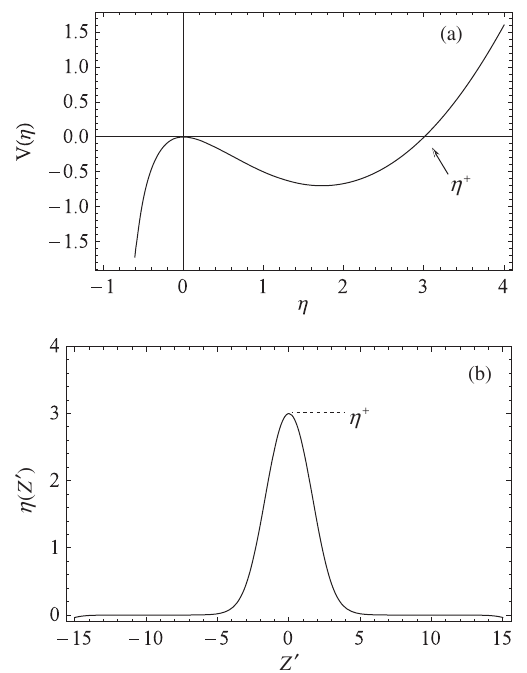
FIG. 7. Plots of (a) V ð η Þ versus η ; and (b) η ð Z 0 Þ versus Z 0 , obtained from Eqs. (56) and (62) for M 2 ¼ 4 , ϵ corresponding to soliton amplitudes η þ ¼ 3 . 0